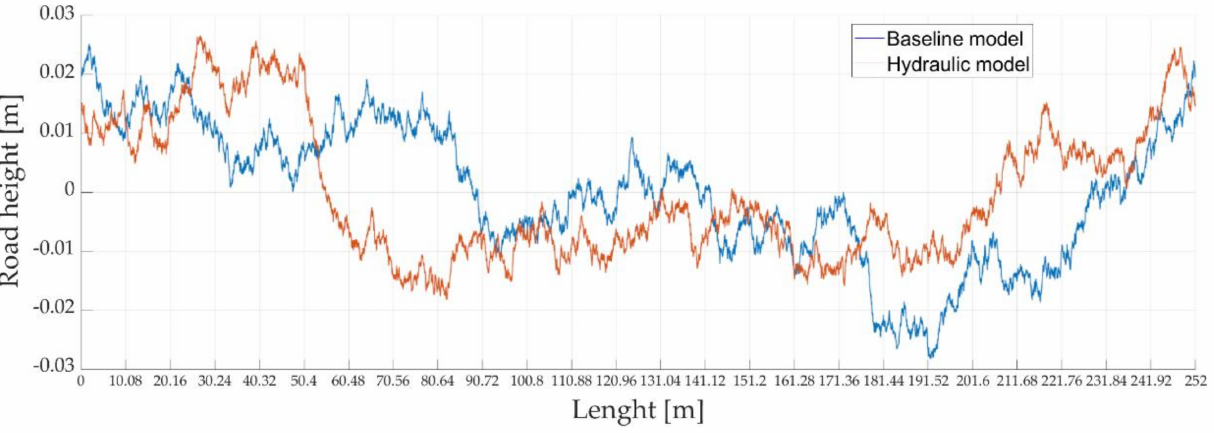
Figure 9. Example of a generated class A road profiles.